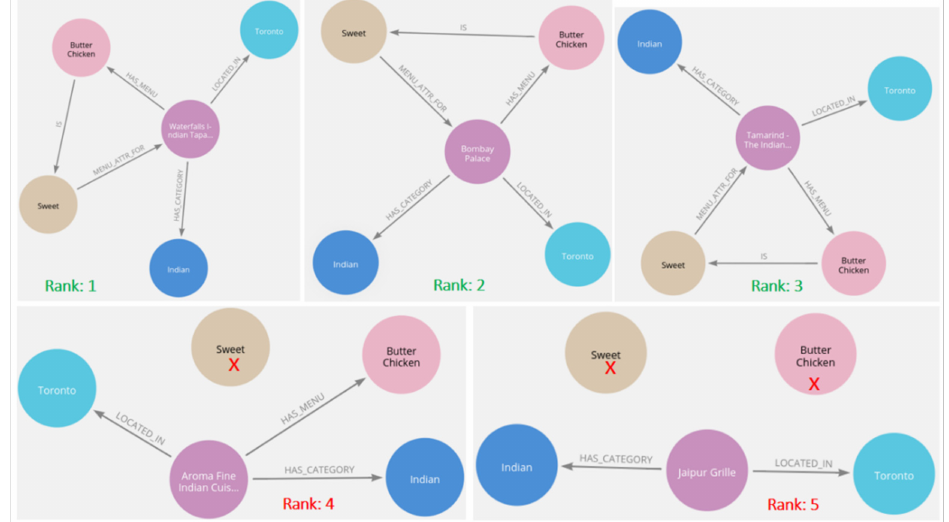
Figure 11. Visualization of explainable results from the domain KG for candidates, obtained from the Q2B model.